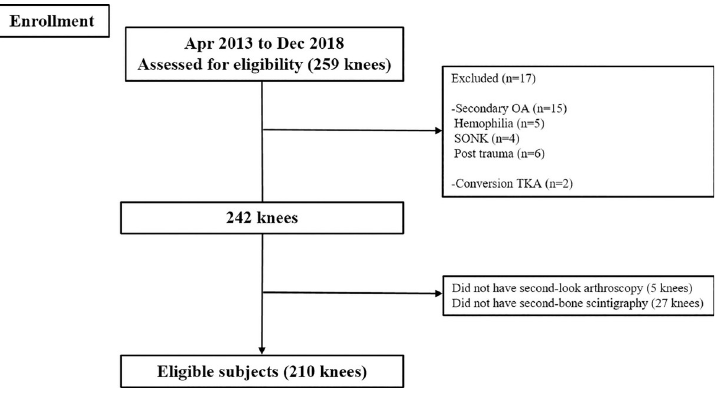
Fig 1. Flow diagram showing the number of knees that met the study